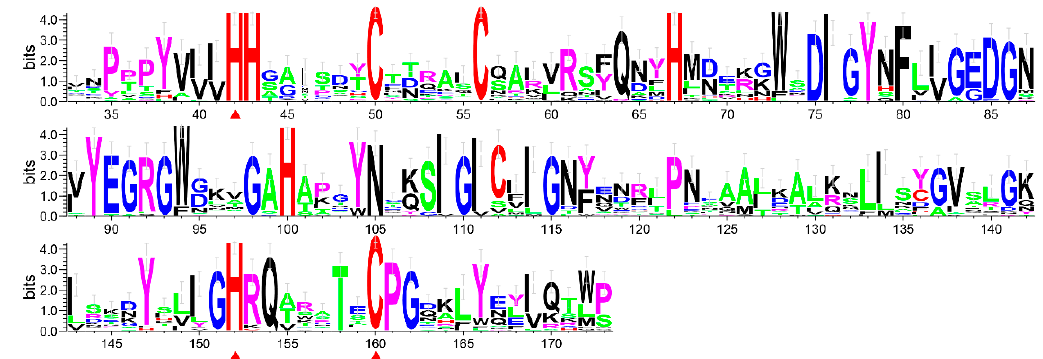
Figure 2. Conserved amino acid sites of the catalytic PGRP protein sequences from the insect species of D. melanogaster , A. mellifera , N. vitripennis , P. puparum and the 12 fig wasp species. The three key conserved Zn 2 + -coordinating residues of His 42 , His 152 and Cys 160 were marked with red triangles Note: ** represents extremely significant difference between the gene numbers of the pollinator and non-pollinator groups ( p < 0.01). (Number of location sites were taken from the gene of Dmel-PGRP-LB from D. melanogaster ). Table 2. The number of catalytic PGRP genes of pollinator and non-pollinator species. Group Name Gene Number Significance